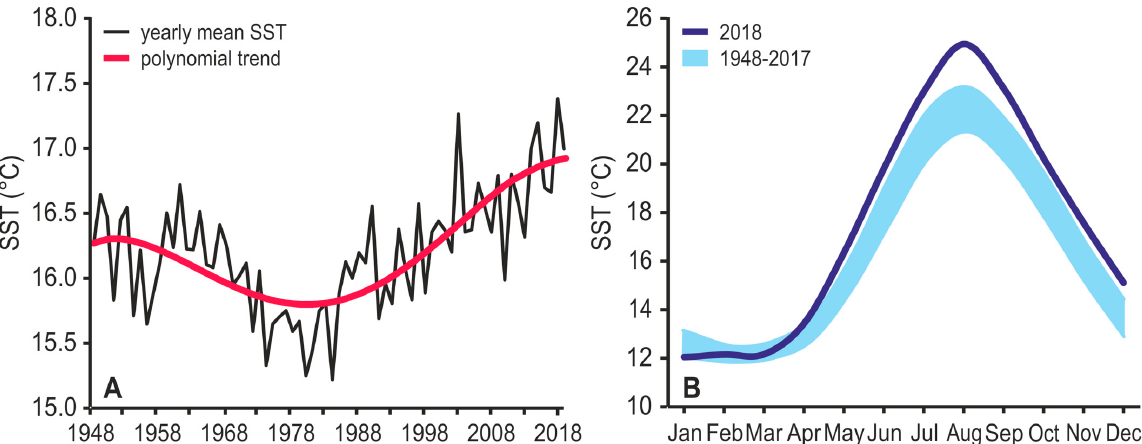
Figure 3. ( A ) Fourth-degree polynomial trend (r = 0.75) of the yearly mean sea surface temperature (SST) values in the Portofino MPA from 1948 to 2019. ( B ) The 2018 SST monthly values compared to the SST overall monthly mean values of the previous 70 years. The SST values were derived from NOAA satellite data (www.esrl.noaa.gov/psd/cgi-bin/data/timeseries/timeseries1.pl, accessed